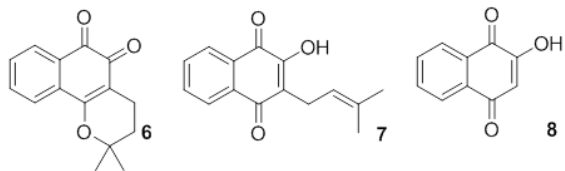
Figure 2 – Structures of three important natural naphthoquinones and some related